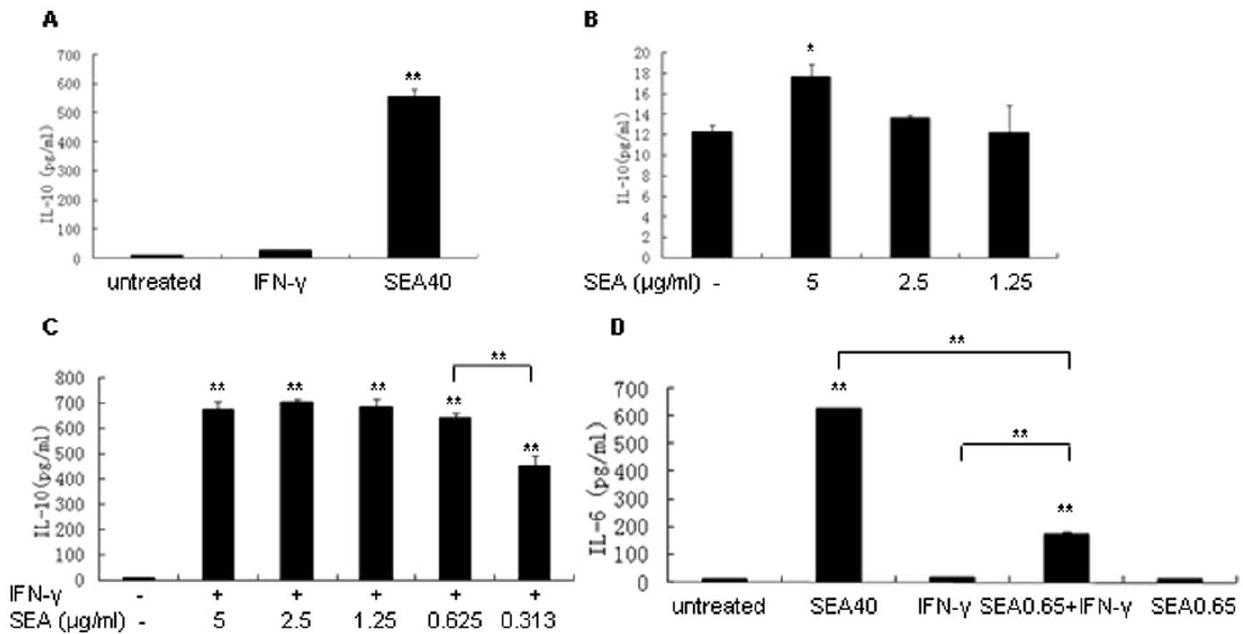
Figure 2. IFN- c promoted the production of IL-10 and IL-6 induced by SEA from RAW 264.7 cells. (A) IL-10 production tested by ELISA in supernatants of RAW 264.7 cells stimulated with IFN- c (4 ng/ml), 40 m g/ml of SEA (SEA40), or cultured with medium alone (untreated). (B) IL-10 production tested by ELISA in supernatants of RAW 264.7 cells stimulated with 5, 2.5, 1.25 m g/ml of SEA or cultured with medium alone. (C) IL-10 production tested by ELISA in supernatants of RAW 264.7 cells stimulated with 4 ng/ml of IFN- c and serially diluted SEA from 5 m g/ml to 0.313 m g/ml simultaneously or RAW 264.7 cells cultured with medium alone. (D) IL-6 production in supernatants of RAW 264.7 cells stimulated with 40 m g/ml of SEA (SEA40), 4 ng/ml of IFN- c , 0.65 m g/ml of SEA and 4 ng/ml of IFN- c simultaneously (SEA0.65 + IFN- c ), 0.65 m g/ml of SEA (SEA0.65), and cultured with medium alone (untreated). (* P , 0.05, ** P , 0.01, Duncan’s multiple range test).